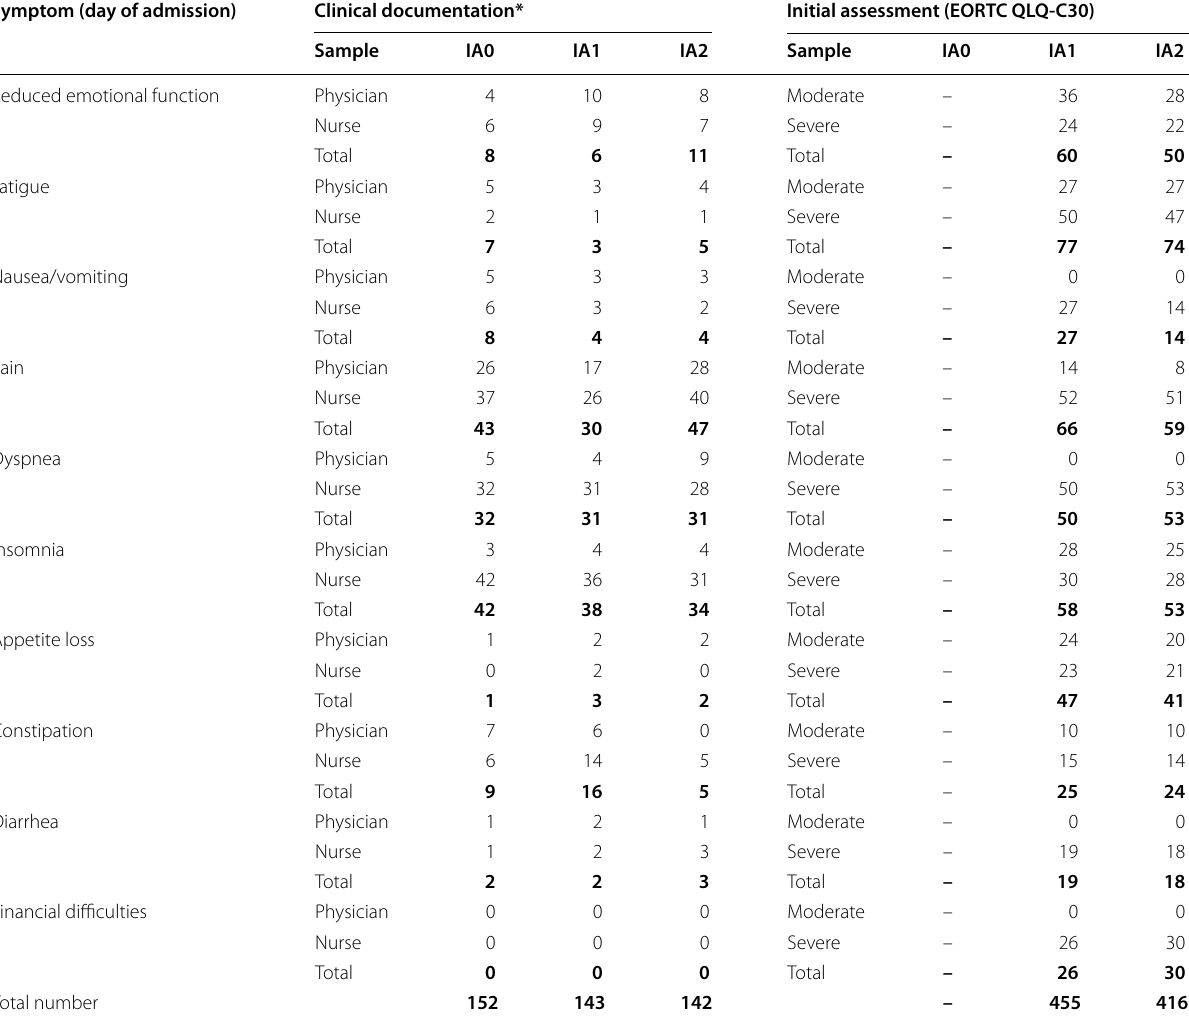
Table 1 Comparison of clinical records and initial assessment regarding the number of identified symptoms (n